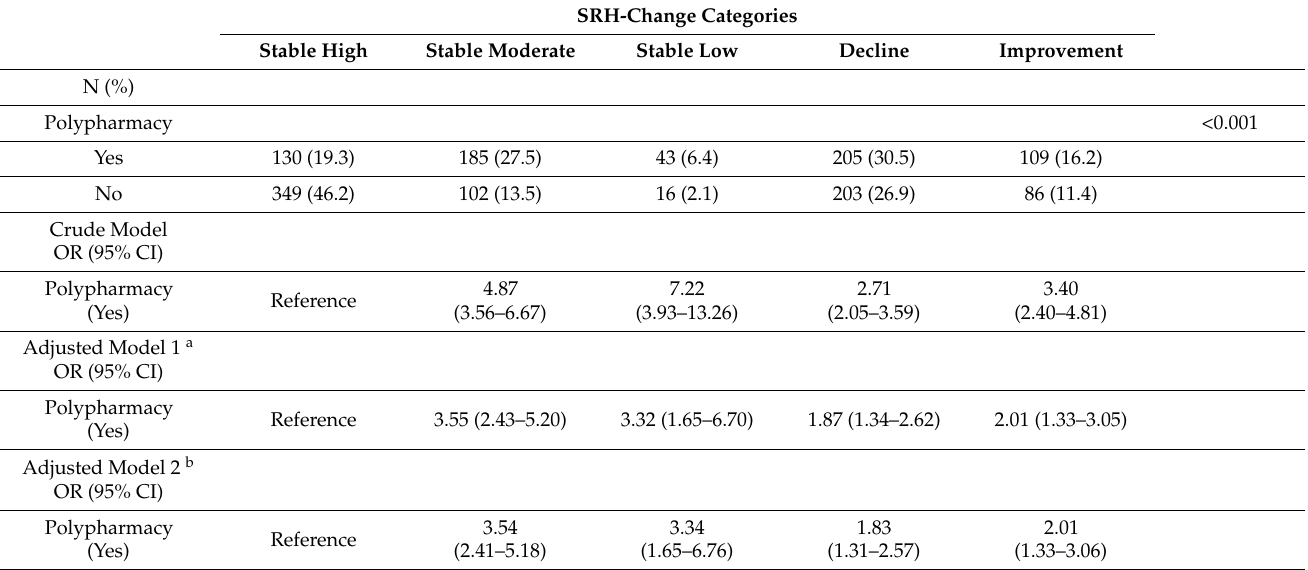
Table 3. Multinomial regression model showing the association between polypharmacy and SRH- change